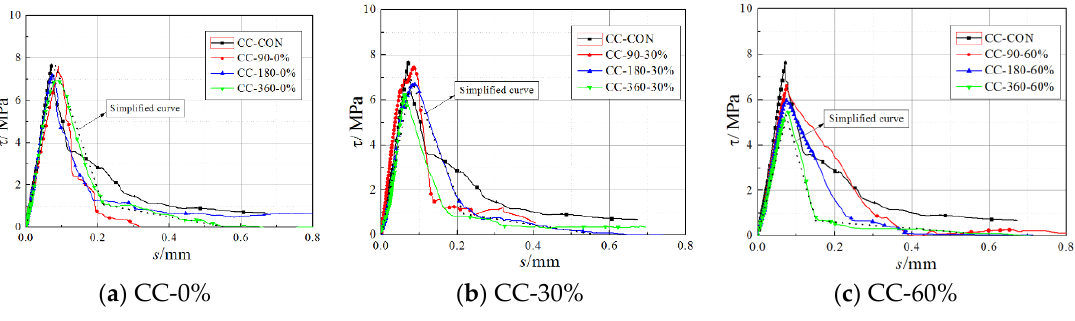
Figure 2. Local bond-slip curve of the specimens.